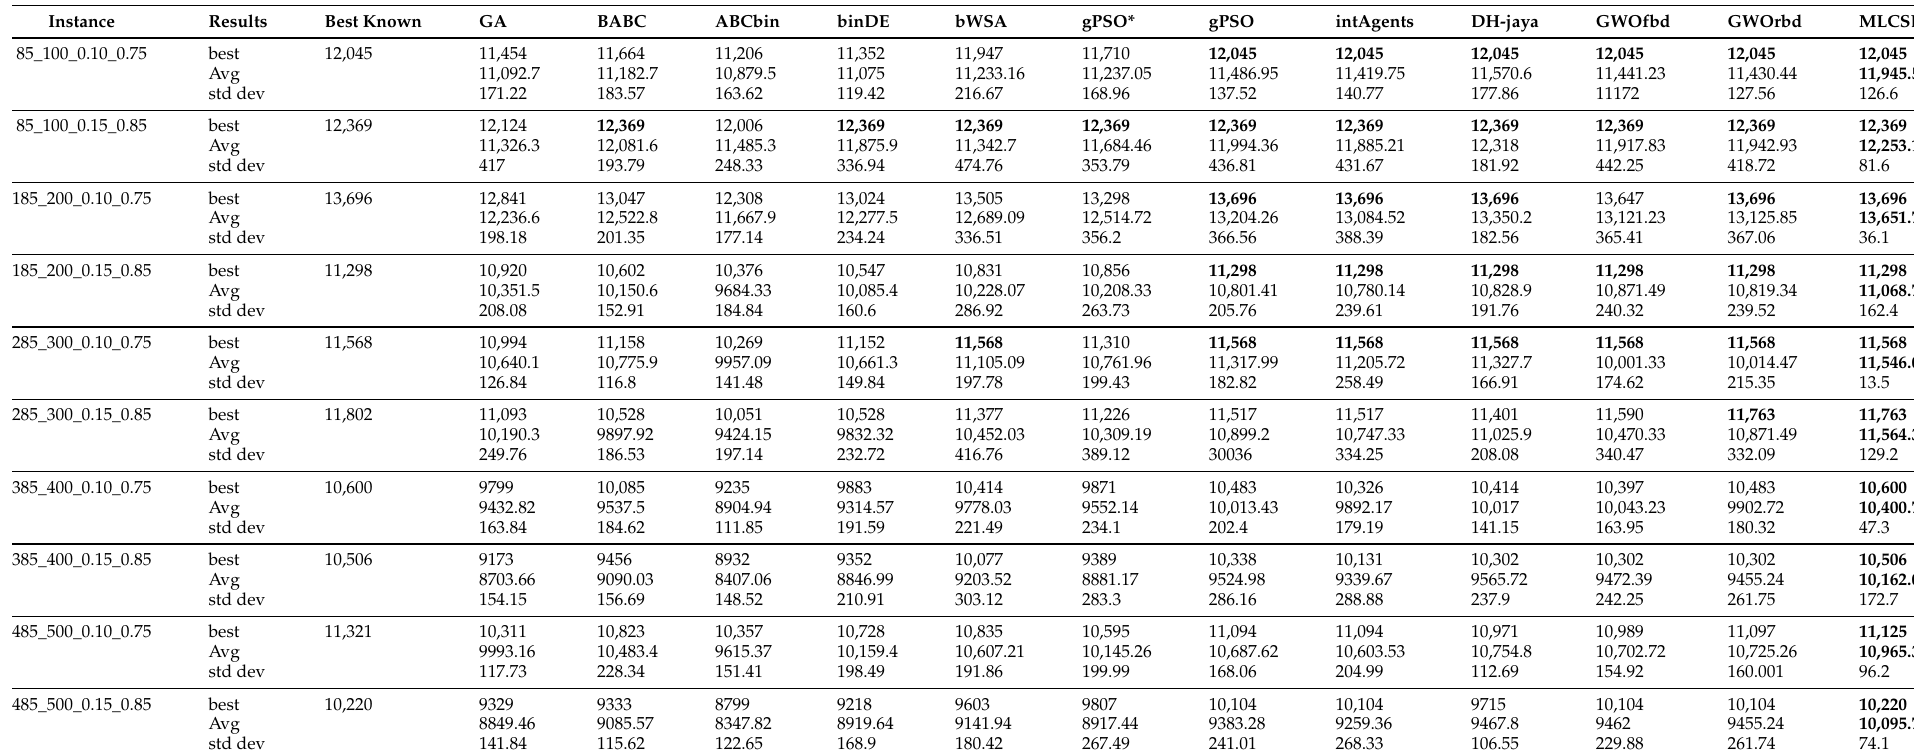
Table 7. Comparison between GA, BABC, ABC bin, gPSO*, gPSO, intAgents, DH-Jaya, GWOfbd, GWOrbd and MLCSBO algorithms for medium